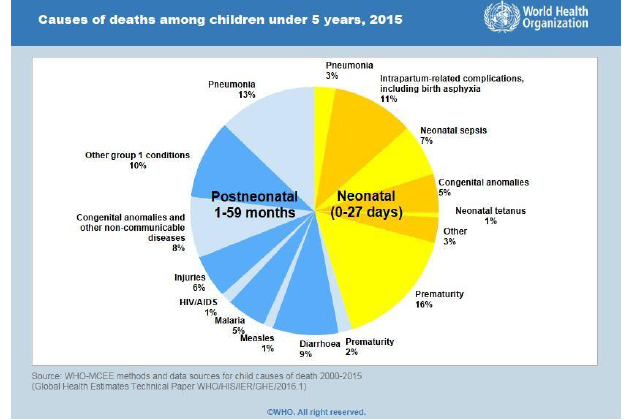
Figure 3 : Method and data sources for child causes of death 2000-2015 (large number of deaths caused are preventable through immunization, which motivates our nudge-based immunization education